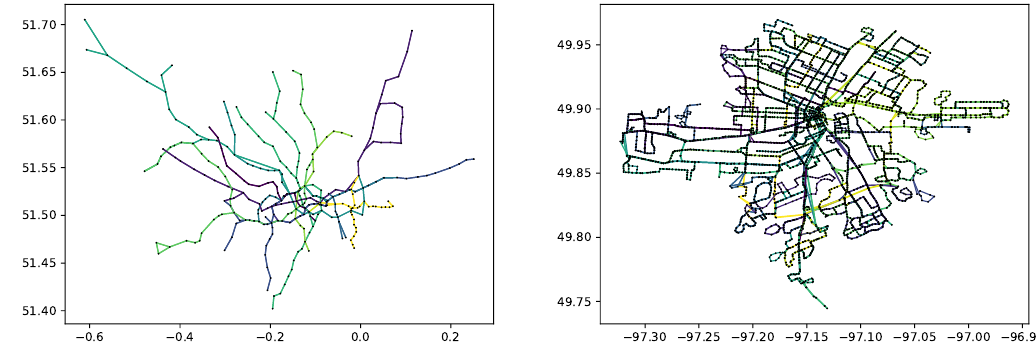
Figure 9. Public transport networks for the London Underground ( left ), and the city of Winnipeg ( right ). Vertices are positioned according to GPS coordinates.